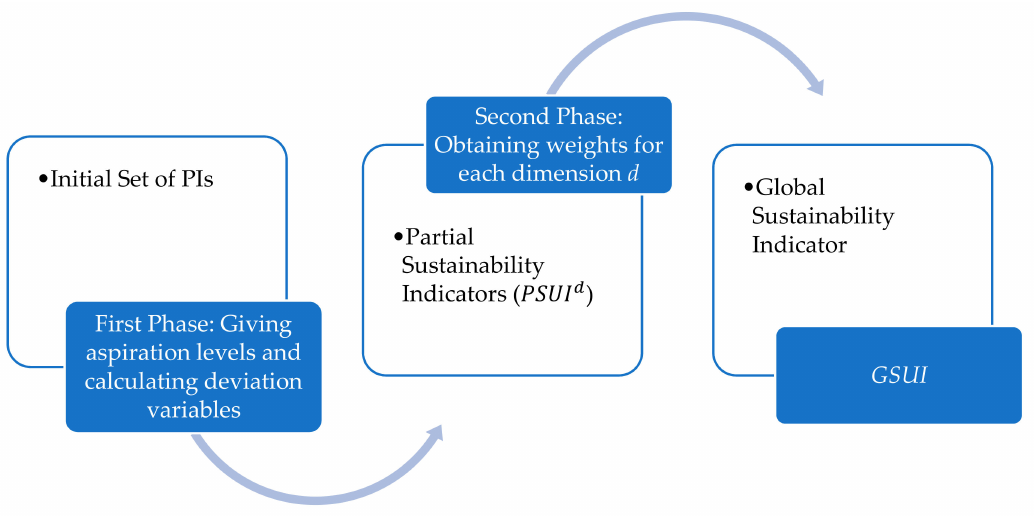
Figure 1. General scheme of the proposed